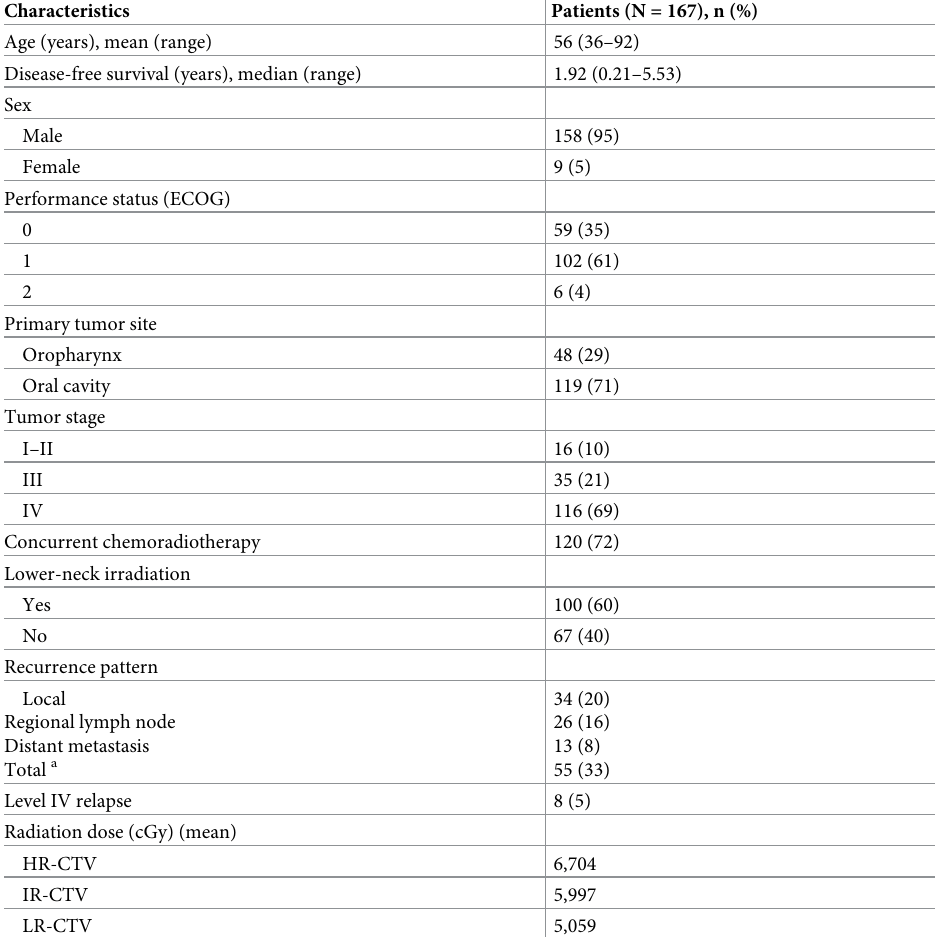
Table 1. Patient